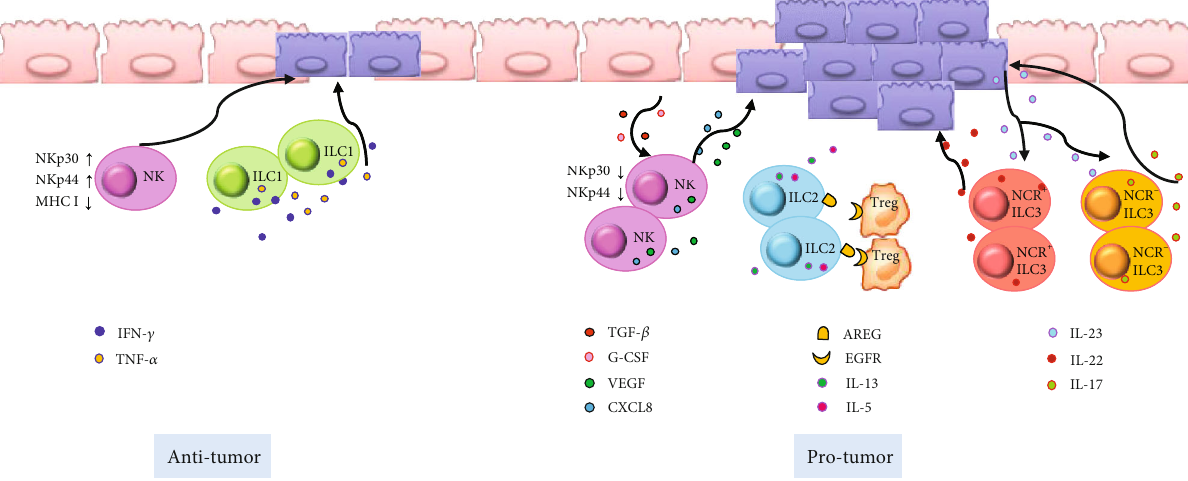
Figure 3: Potential pro- and antitumorigenic roles of ILCs in intestinal cancer. NK cells express high levels of the activating receptors NKp30 and NKp44 and contribute to the fi ght against tumor cells. Under the in fl uence of transforming growth factor beta 1 (TGF- β ) and granulocyte colony-stimulating factor (G-CSF), NK cells also have a tumor-promoting e ff ect. ILC1s might be involved in antitumor immunity through the release of IFN- γ and TNF- α . ILC2-derived cytokines, IL-5 and IL-13, are associated with a high risk of developing in fl ammation-driven colorectal cancer. ILC2-derived AREG stimulates regulatory T cells and establishes an immune-suppressive tumor microenvironment. In response to IL-23 stimulation, NCR + ILC3s and NCR − ILC3s mainly produce IL-22 and IL-17, respectively. The IL-23 – ILC3 – IL-22/IL-17 axis is a critical pathway that promotes tumor